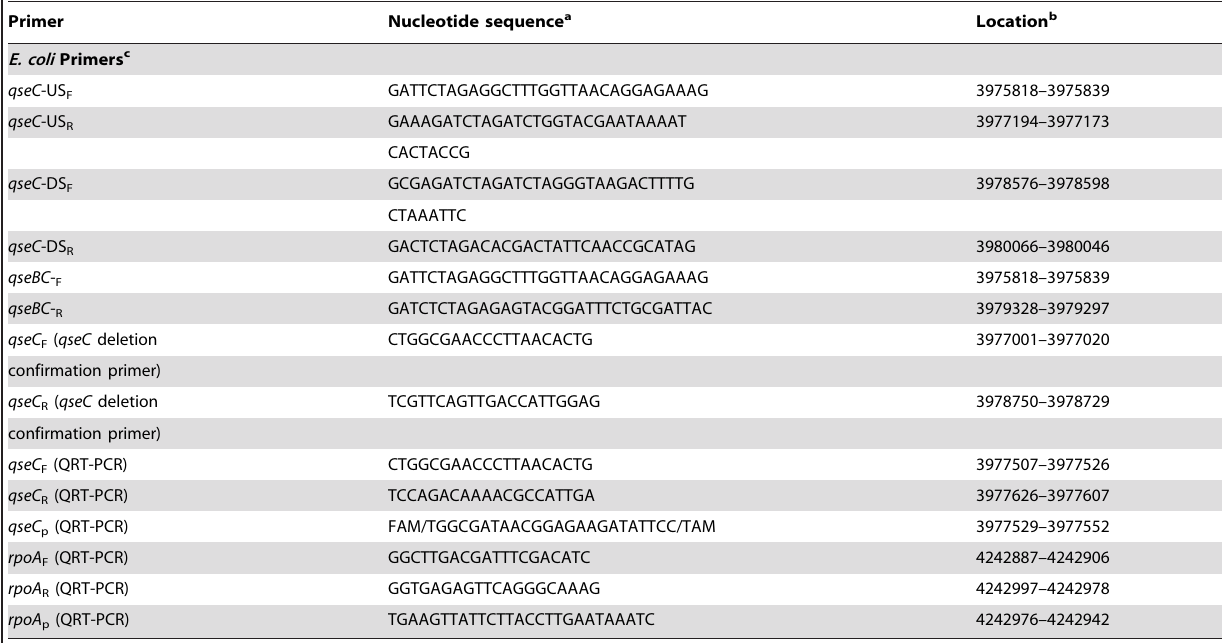
Table 2. Primers used for PCR and